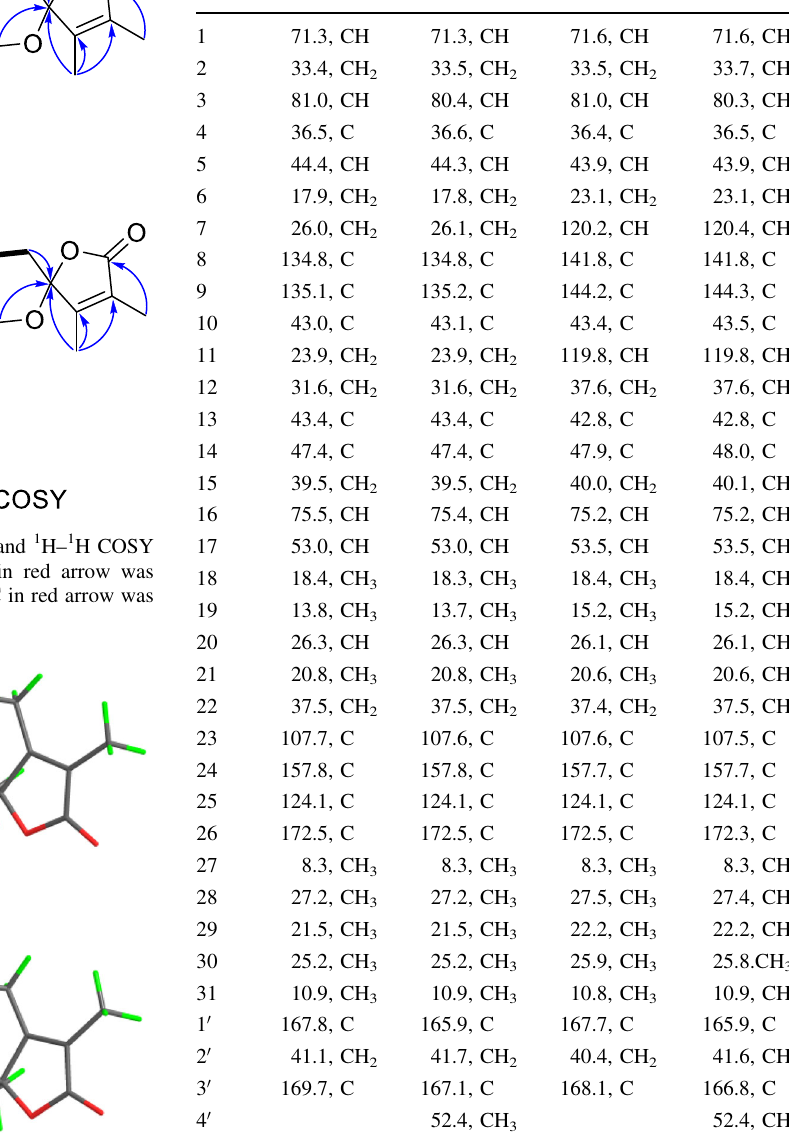
Table 2 13 C NMR spectroscopic data for compounds 1 – 4 (CDCl 3 )